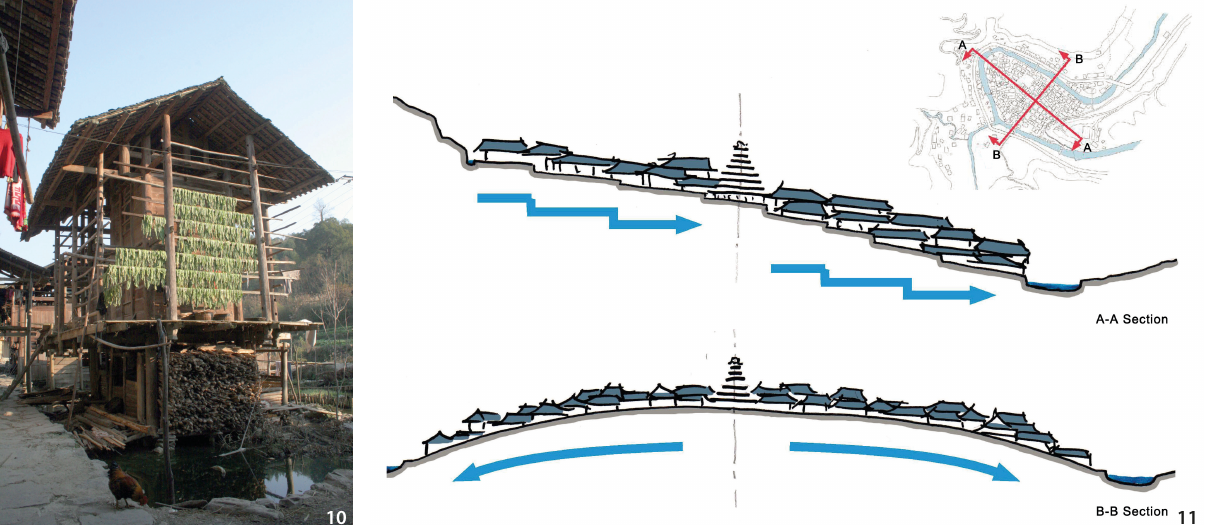
Figure 10 Barn upon pond (Source: Cultural Relics Protection Centre of Guizhou Province). Figure 11 Micro-topography adjustment (Source: outcome of Zengchong Chinese-French